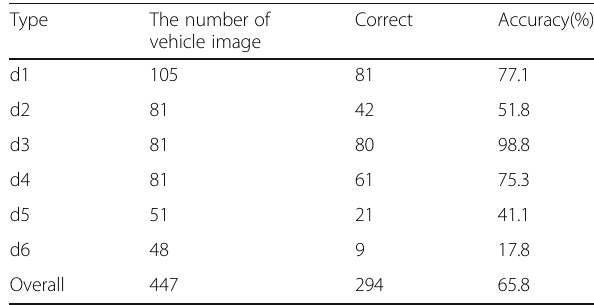
Table 2 Accuracy of vehicle classification by the visual image